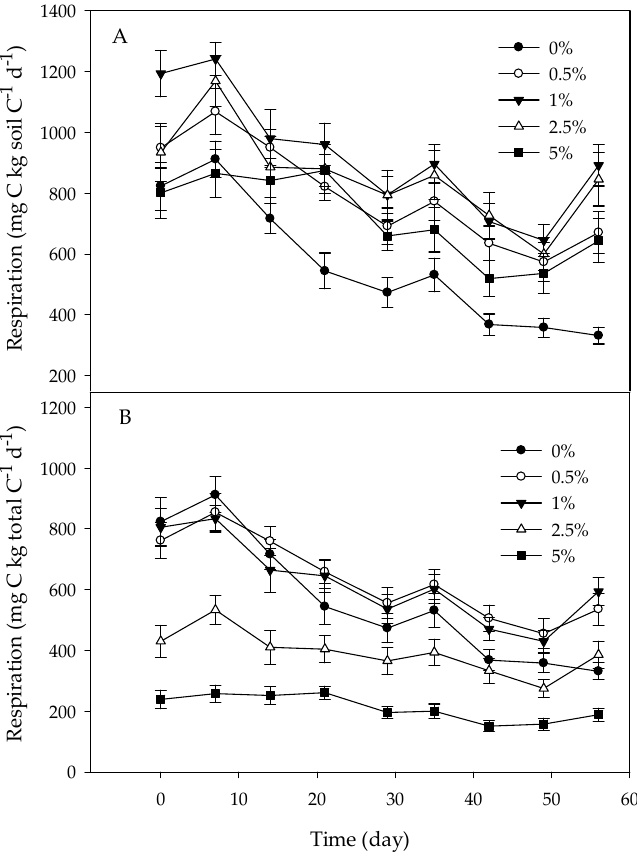
Figure 3. Microbial respiration expressed per g soil C ( A ) or total C (soil C plus charcoal C); ( B ) during a two-month long incubation. Data are pooled by soil type and charcoal type to emphasize the effect of amendment level. Day 0 represents the first measurement day following a one-week pre-incubation period. Error bars represent standard errors of the mean ( n = 12). Results of post-hoc tests assessing differences between amendment levels for each measurement time are shown in Table